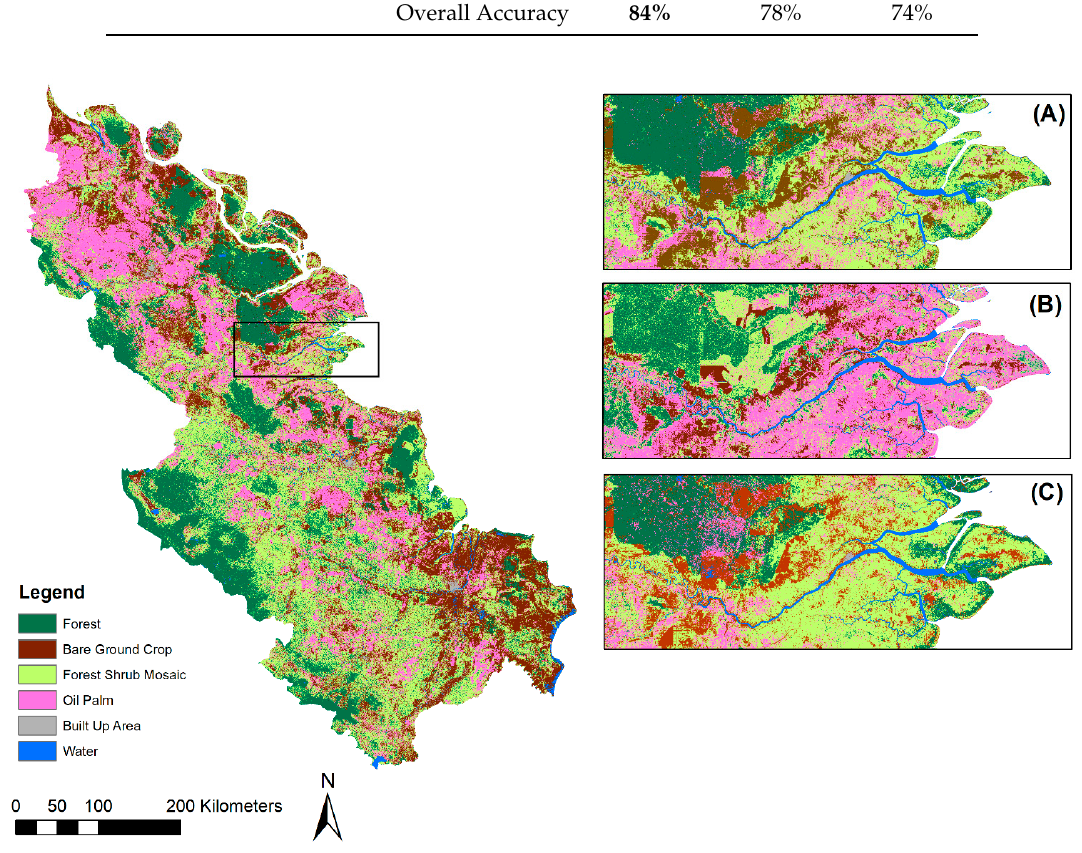
Figure 3. Classified image for Riau, Jambi, and South Sumatra using our Combined image stack. Insets focus on the border of Riau and Jambi for ( A ) Combined, ( B ) SAR, and ( C ) Landsat classified images.